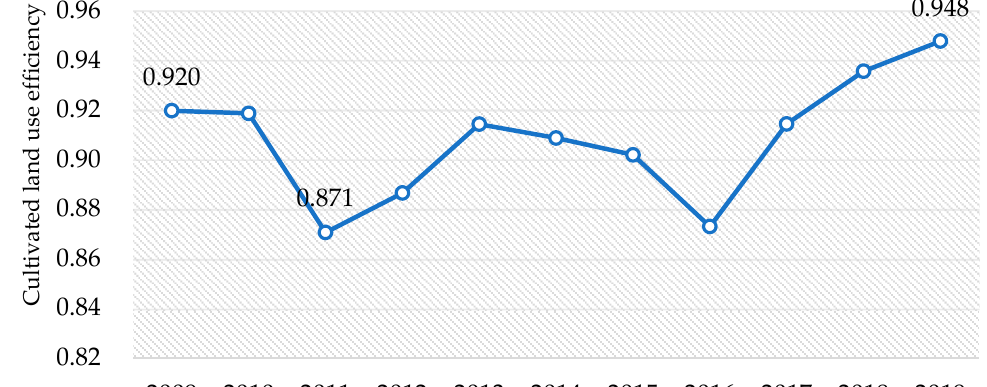
Figure 1. Changes in the average utilization efficiency of cultivated land in China.